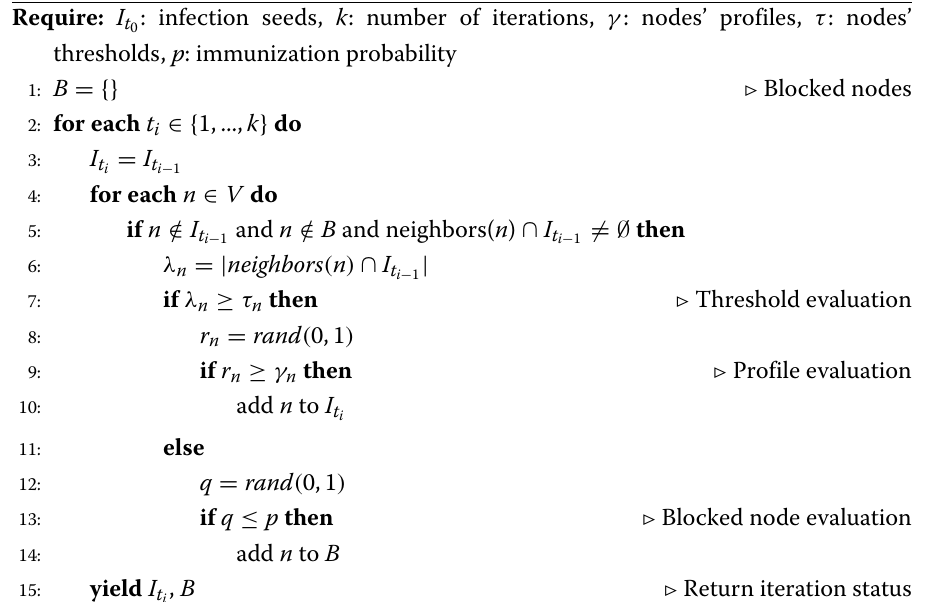
Algorithm 3 Profile-Threshold